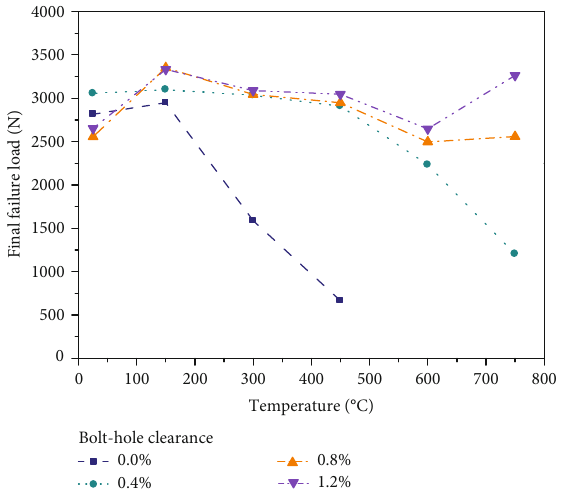
Figure 11: Variation of the failure load with temperature for the studied hybrid CMC/superalloy bolted